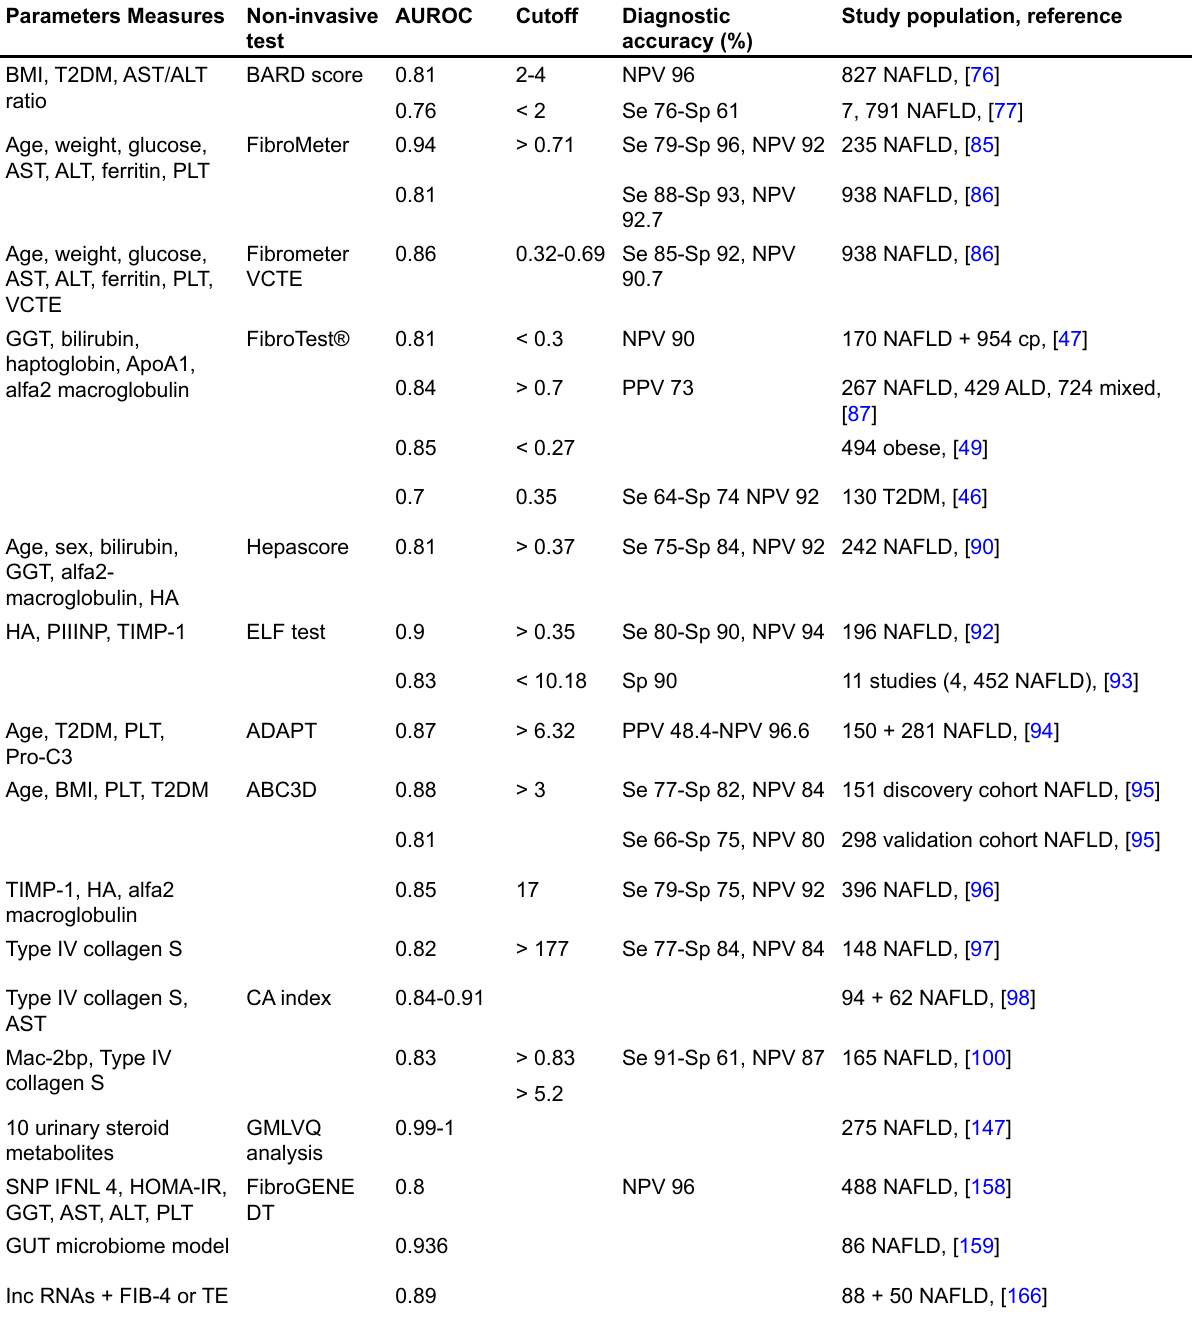
Table 2. Summary of biochemical tests for AF in patients with NAFLD ( continued ) Parameters Measures